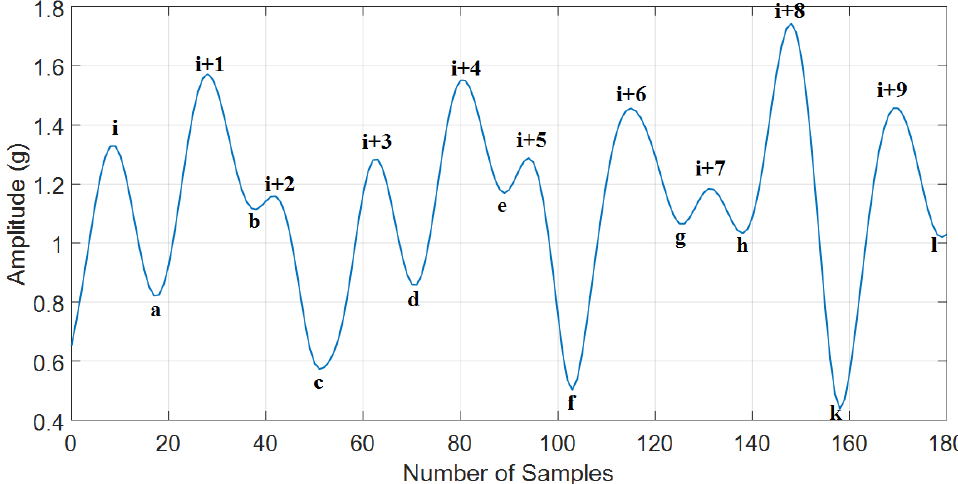
Figure 5. The minimal peak prominence definition.